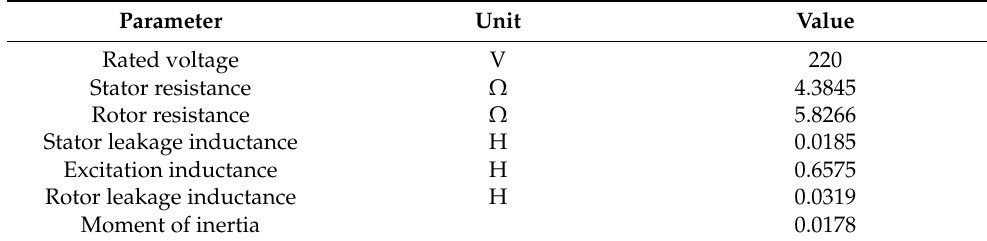
Figure 3. Five − phase induction motor fault − tolerant control block diagram. Table 1. Parameters of five − phase induction motor. Table 1. Parameters of five-phase induction motor.